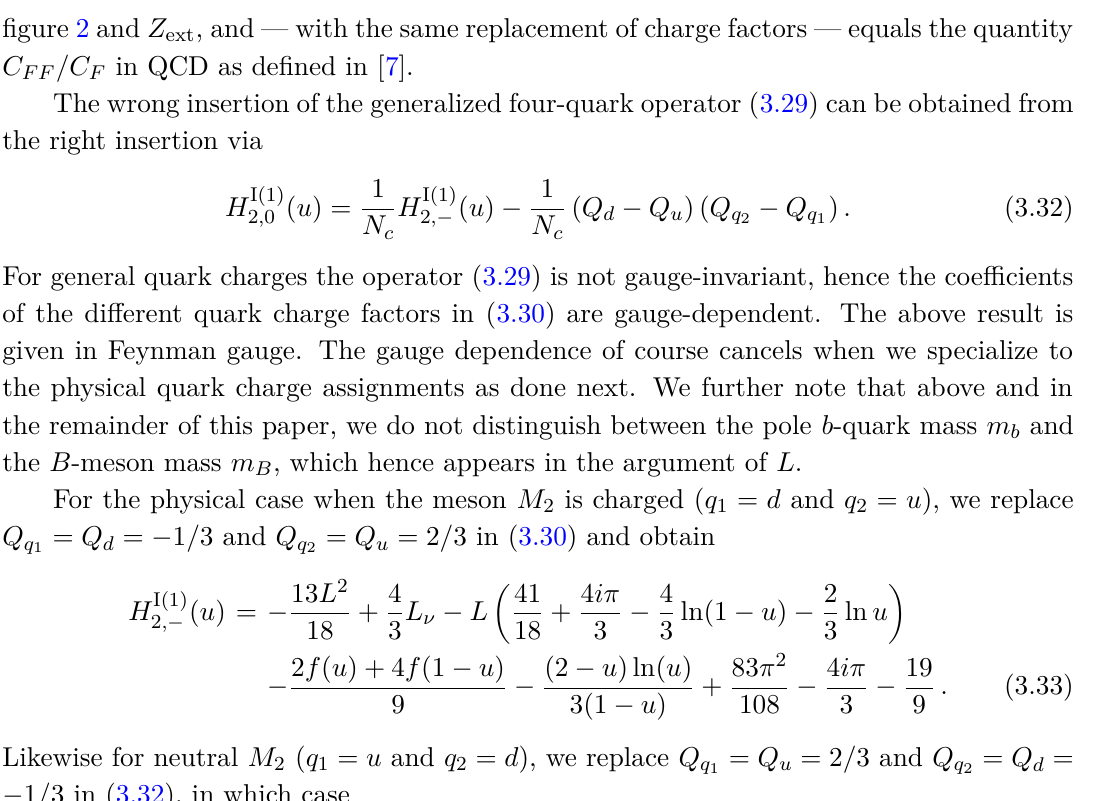
figure 2 and Z , and — with the same replacement of charge factors — equals the quantity ext C /C in QCD as defined in FF F